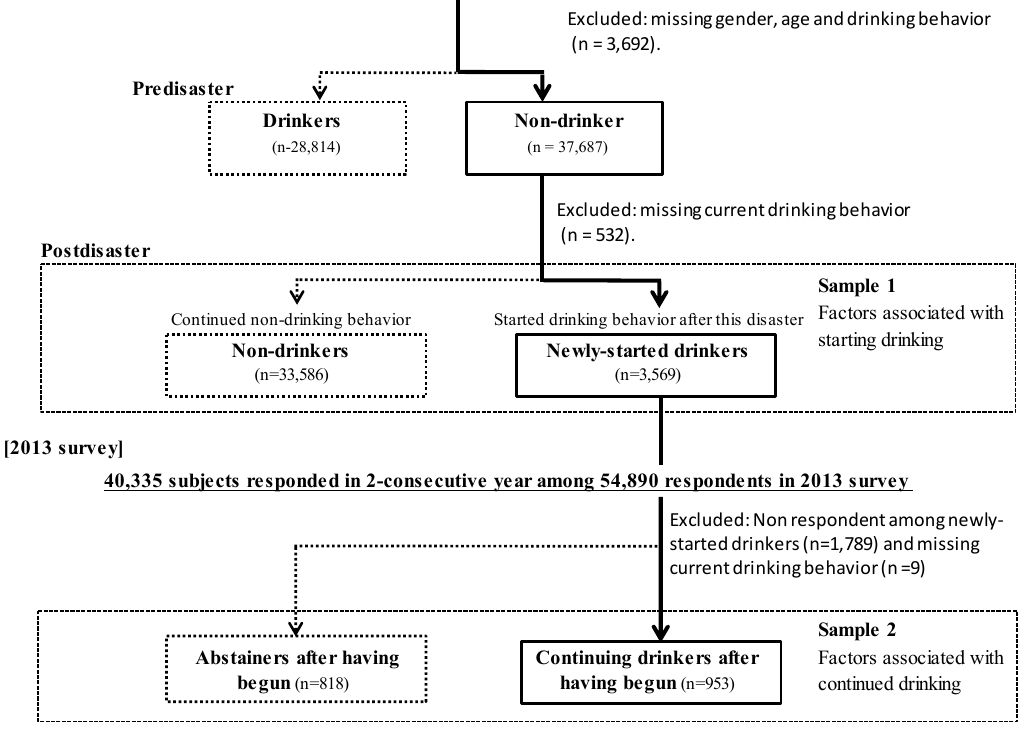
Figure 1. Study Figure 1. Study sample.